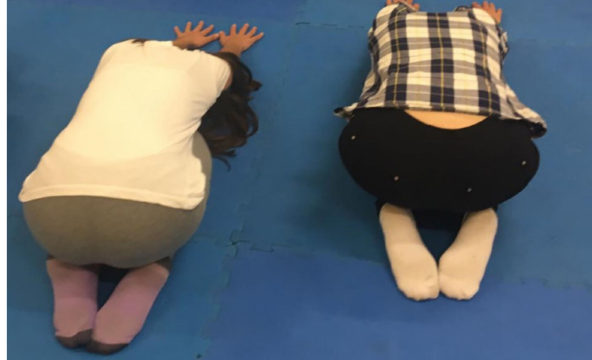
Figure 2. Stretching period for both intervention